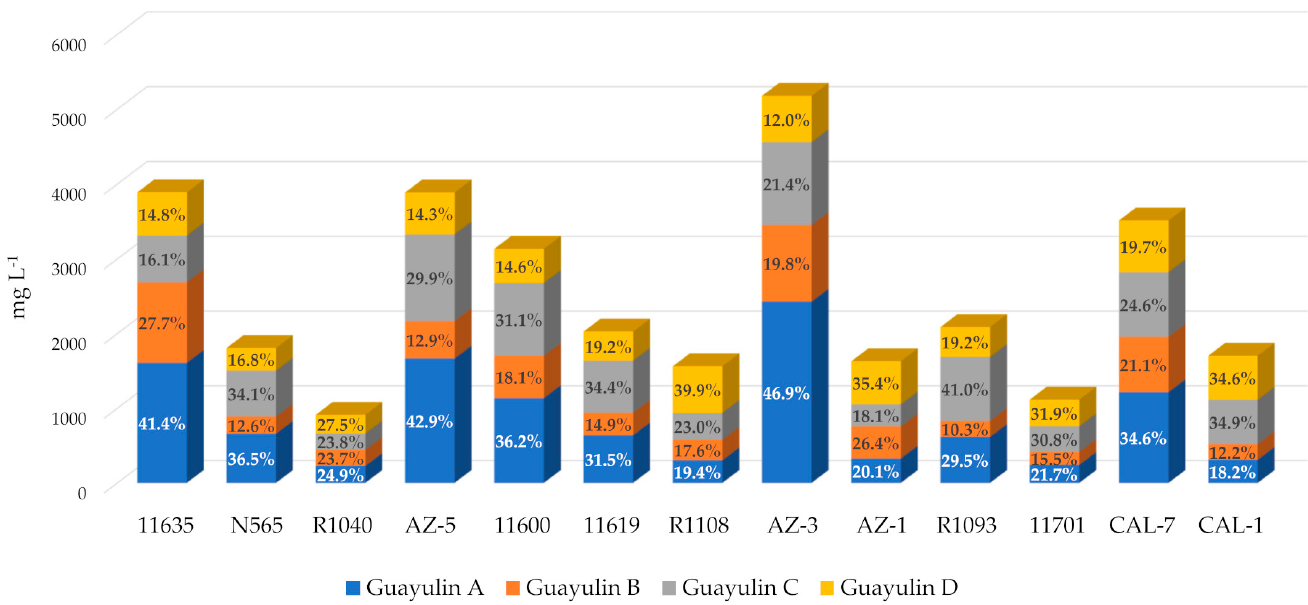
Figure 6. Guayulin content (expressed as mg L − 1 of guayulin A) in leaves at November harvest for each accession. Table 3. Ratio of guayulin B, C and D versus guayulin A content in leaves and stems. Leaves Stems Accession B/A C/A D/A B/A C/A D/A 11600